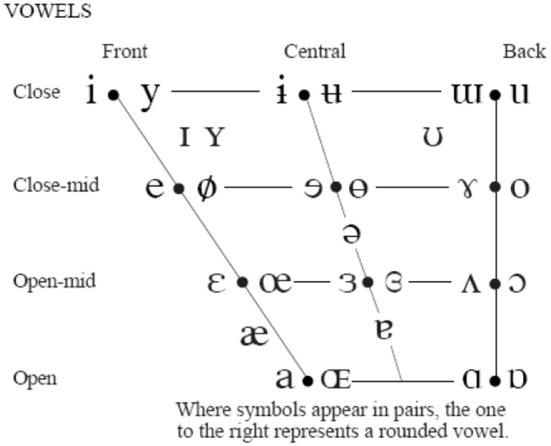
IPA vowel chart.